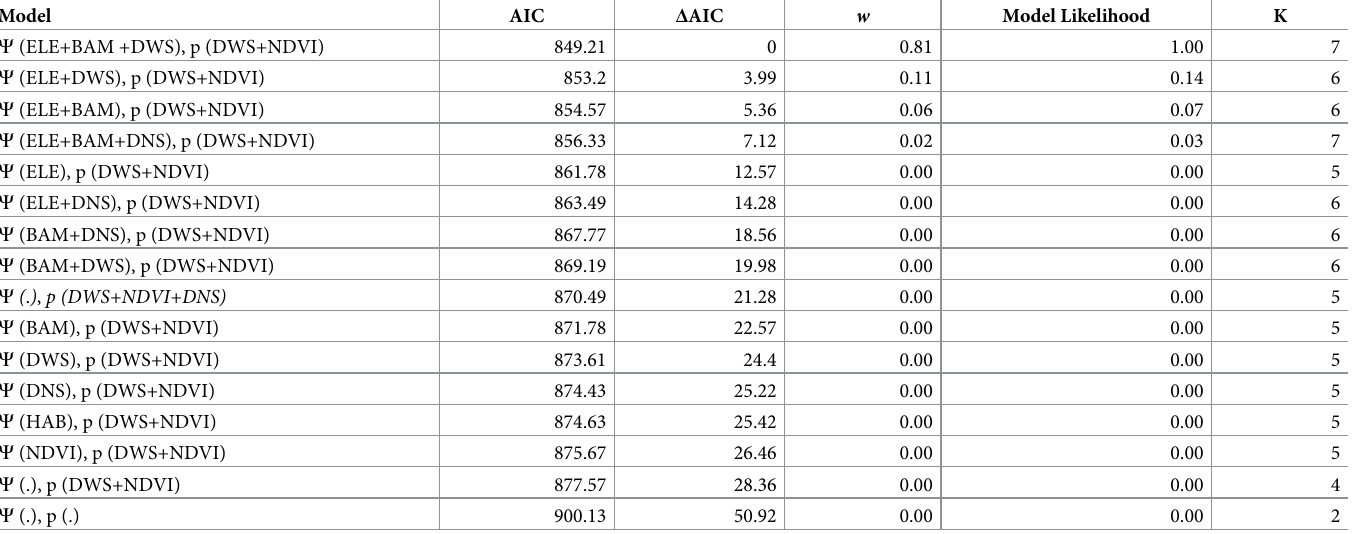
Table 3. Effect of covariates on occupancy ( C ) of red panda across the mid-hills of Nepal. Model AIC